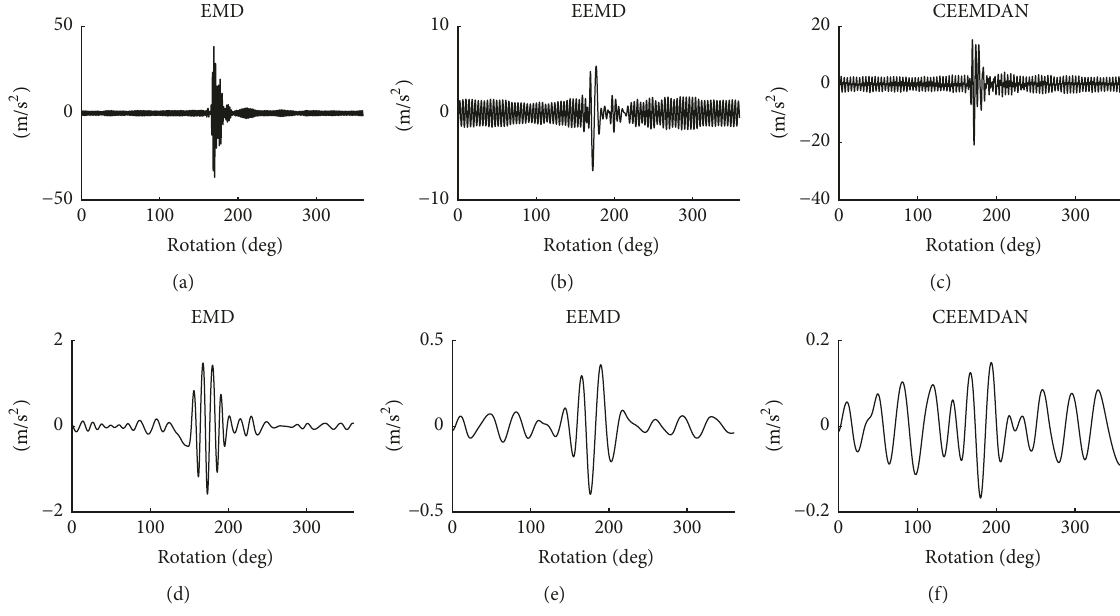
Figure 21: Representative signals of (a–c) gear II and (d–f) gear III for Case